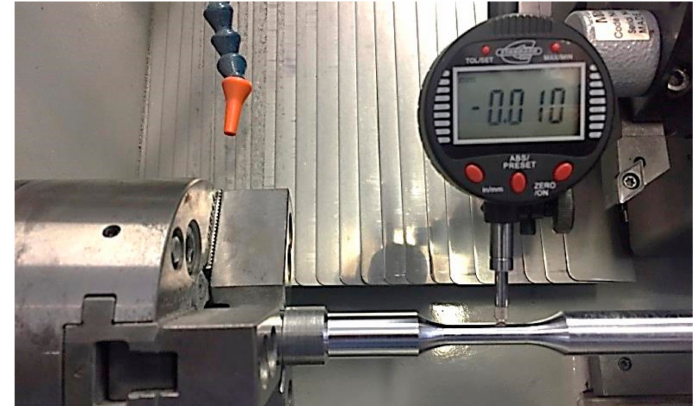
Figure 3. Geometrical control setup on the specimen calibrated